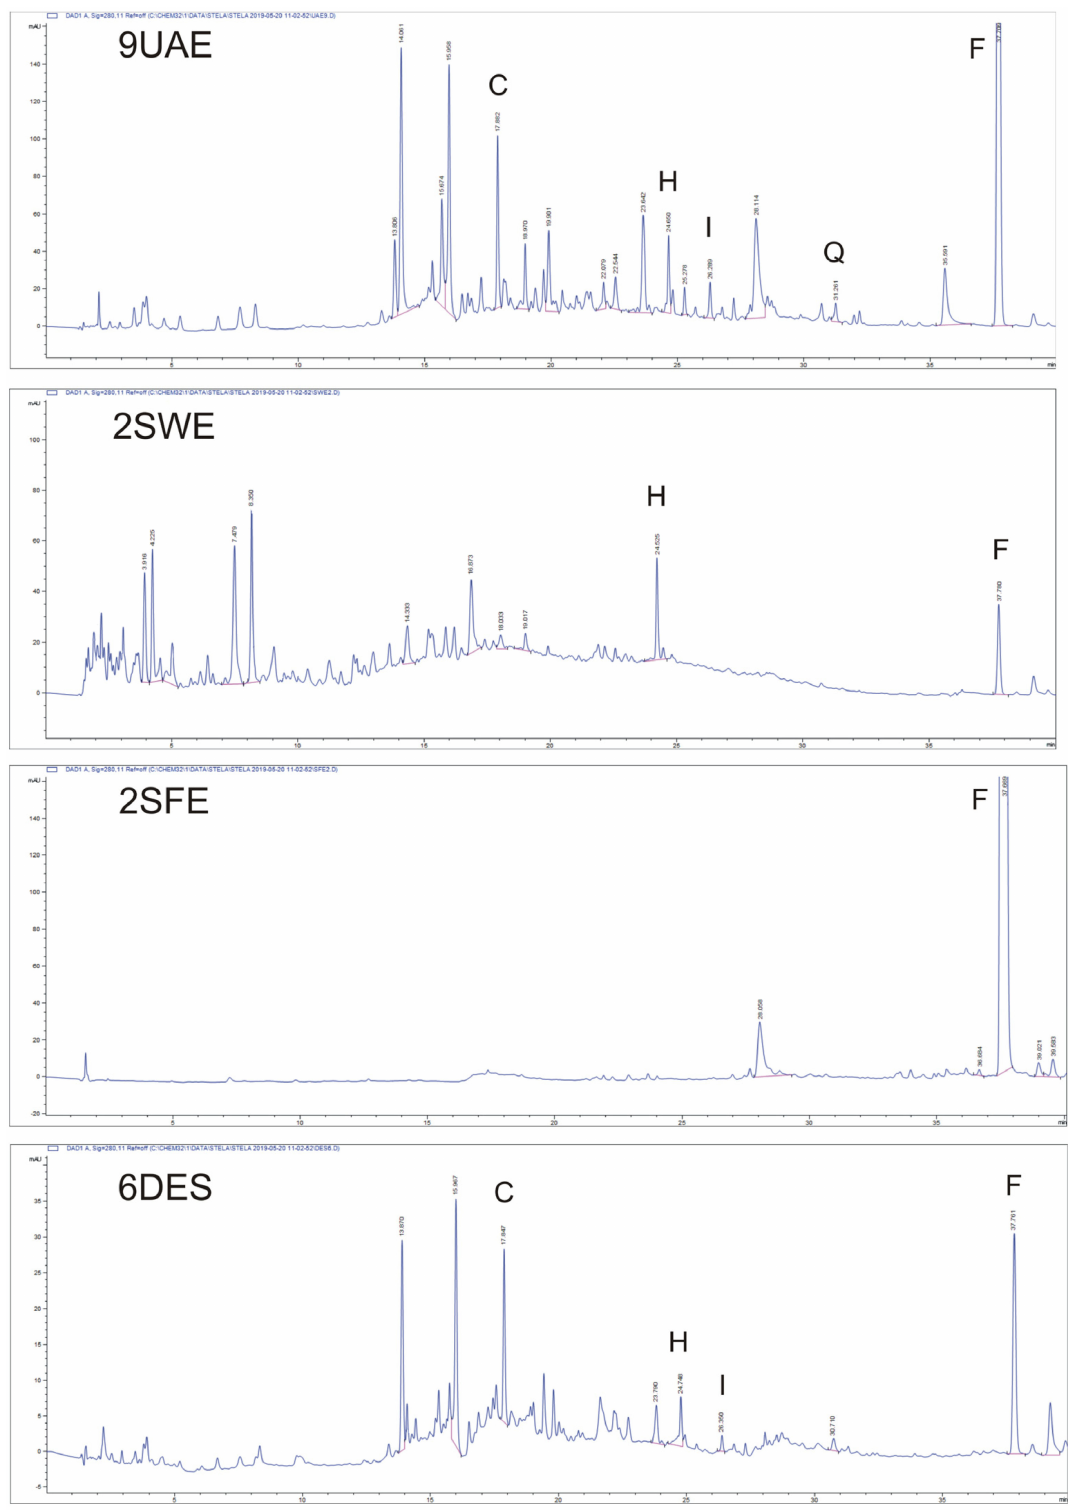
Figure 2. HPLC-PDA fingerprinting for selected samples of the four green extraction techniques (UAE: ultrasound-assisted extraction; SFE: supercritical fluid extraction; SWE: subcritical water ex- traction; DES: deep eutectic solvents) at λ = 280 nm. C: chrysanthemin; H: hyperoside; I: isoquercitrin; Q: quercetin; F: flavone. Chromatographic conditions are described in the